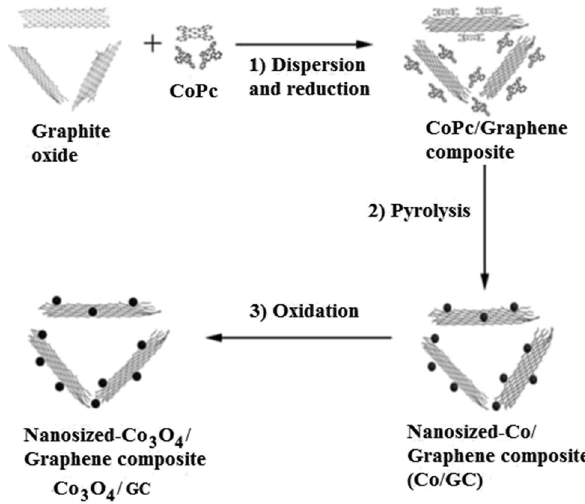
Figure 9: Synthesis of cobalt – graphene nanocomposite ( Co/GC ) through ( 1 ) dispersion of graphite oxide and CoPc using chemical reduction, ( 2 ) pyrolysis at the temperature of 800°C, and ( 3 ) further oxidation to fabricate nanocomposite at 400°C [ 208 ]